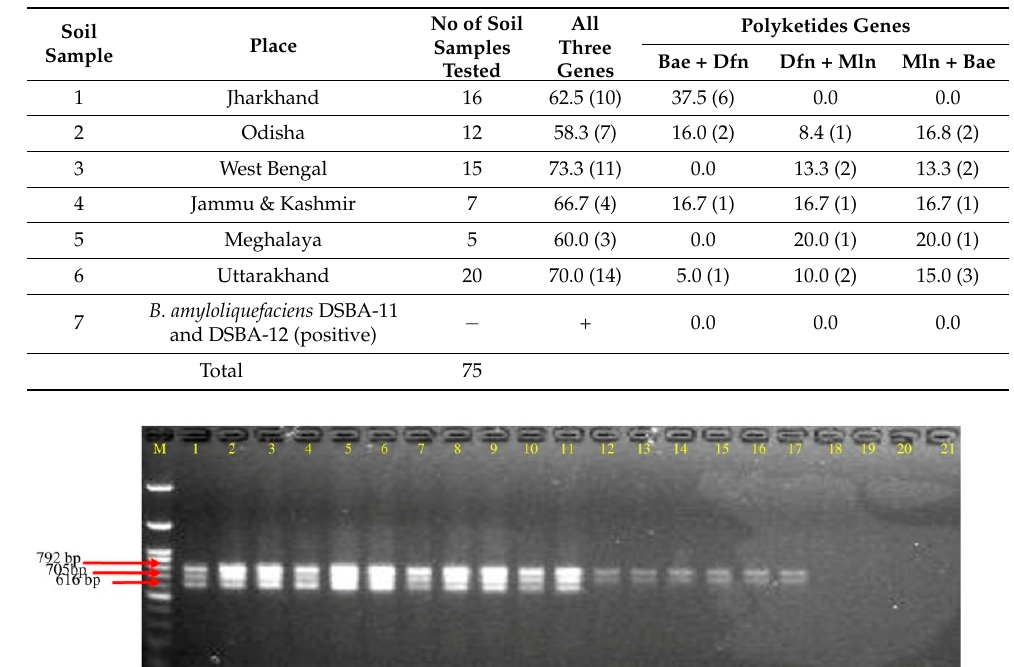
Table 2. List of soil DNA sample used for the detection of polyketides genes by multiplex-PCR.